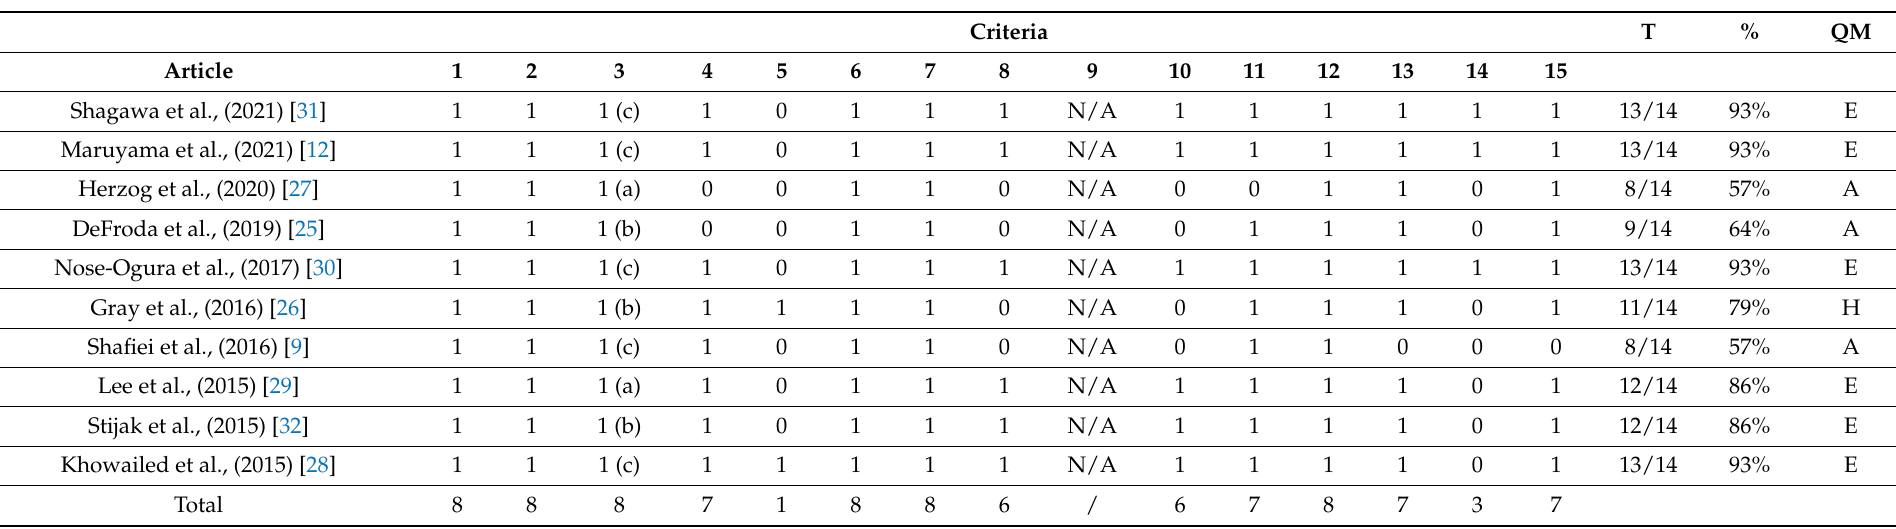
Table 3. Quality Results methodology of the studies included in this